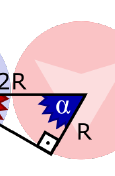
to avoid the two obstacles. Using the angle of 270 ◦ it is possible to notice a new behavior for both models. When the blue agent noticed the approach from the green agent, it started to reduce its own speed preemptively or to turn around in order to avoid future collision. If the red agent notice any movement on the blue agent, it will also move.